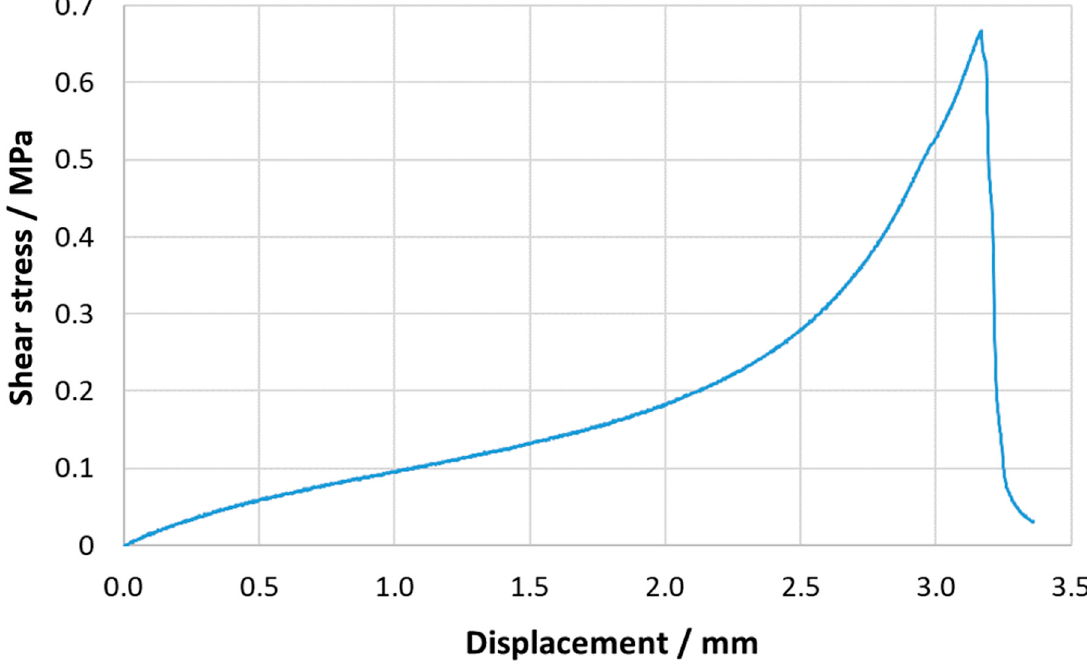
Figure 9. Shear stress–displacement representative curve for the acrylic PSA SLJ quasi ‐ static tests.